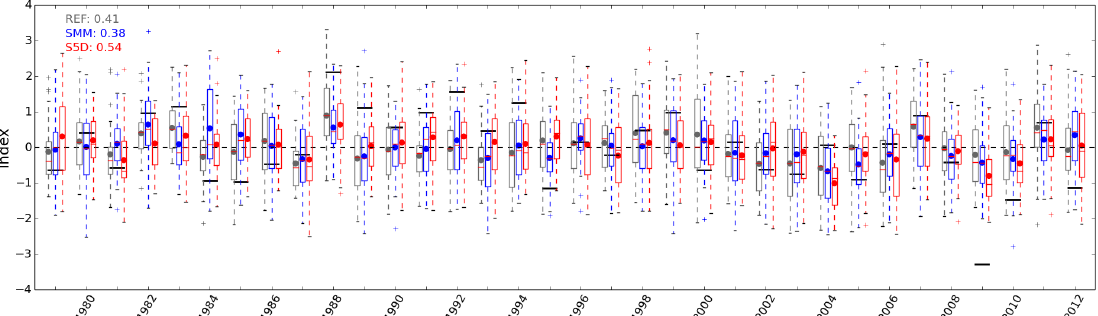
Figure 12. DJF NAO index computed with ERA-Interim 500hPa geopotential height (black lines) and boxplots of ensemble re-forecasts REF (grey), SMM (blue), and S5D (red) NAO indices computed by projecting model anomalies on the ERA-Interim NAO pattern. Anomalies and NAO indices are computed in cross-validation mode. The correlation between the ensemble mean and ERA-Interim index is shown in the top left corner of the figure. Table 2. Weather regime frequencies and mean duration (in days) for ERA-Interim and experiments REF, SMM, and S5D (weather regimes are defined for a duration of 3 days or more, so frequencies do not sum up to 100%). NAO + Blocking NAO − Atl. ridge ERA-Interim